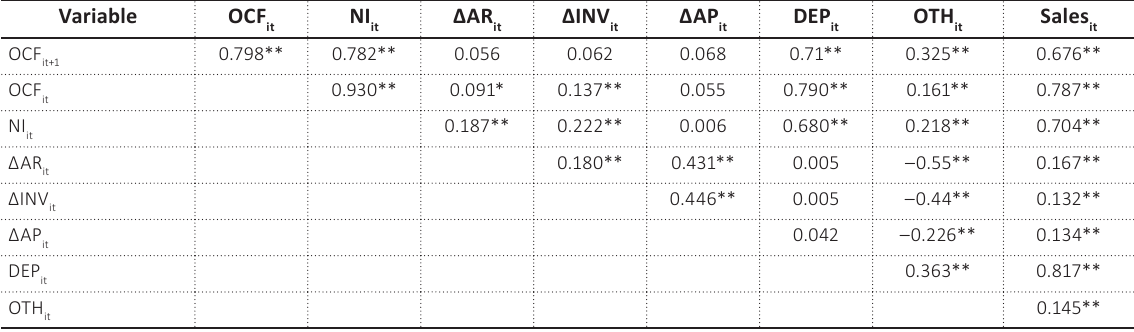
Table 2. Correlation matrix